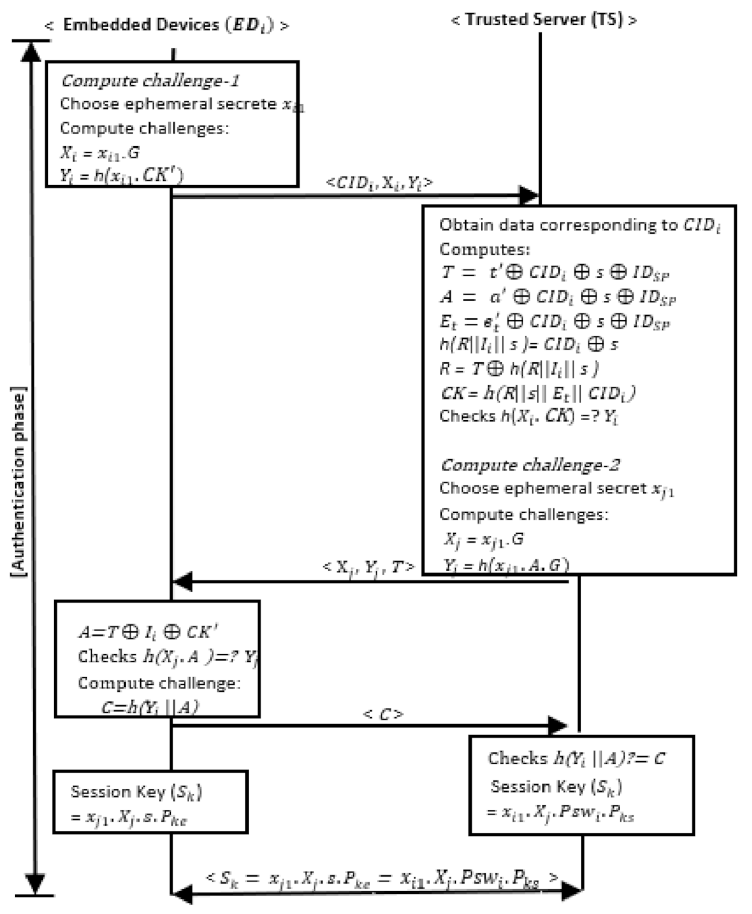
Figure 2. Proposed ECC-based login